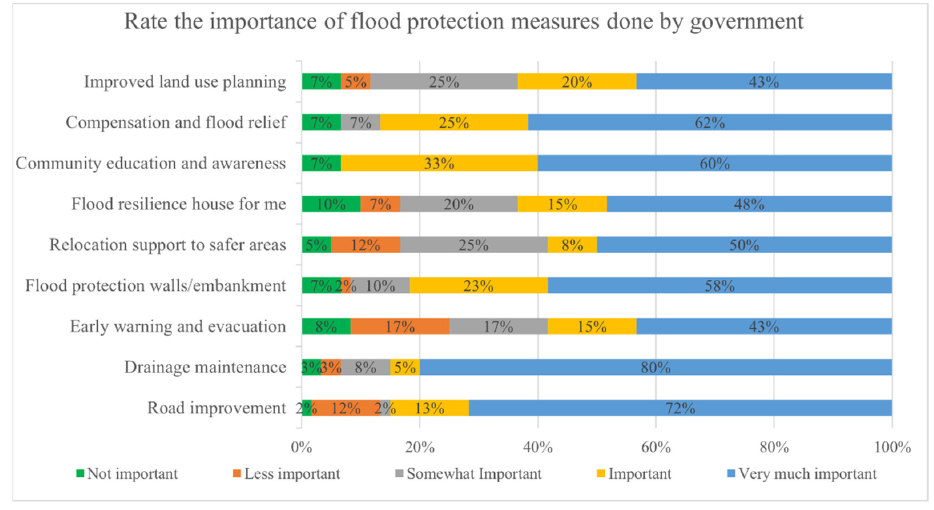
Figure 5. Importance of government flood protection measures conducted in Kaduwela DSD.